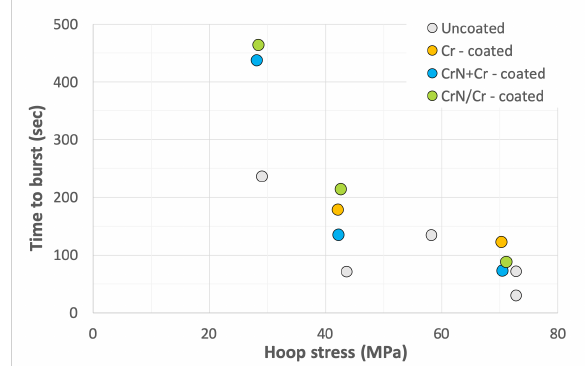
Figure 3. Time to burst at temperature 800 ◦ C in relation to the hoop stress for different types of coatings and uncoated specimens